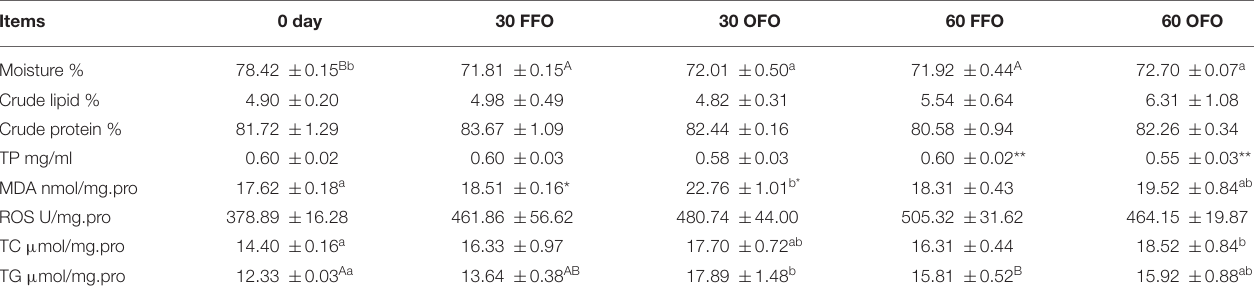
TABLE 3 | Muscle composition and biochemical index of grouper fed different